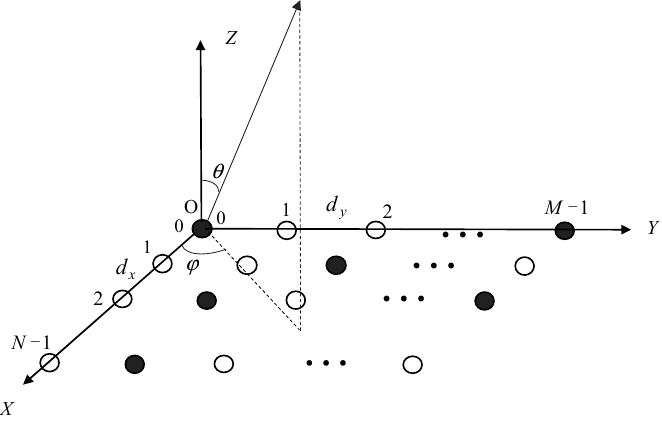
Figure 1. A planar array with some elements “ON” and the others “OFF”.